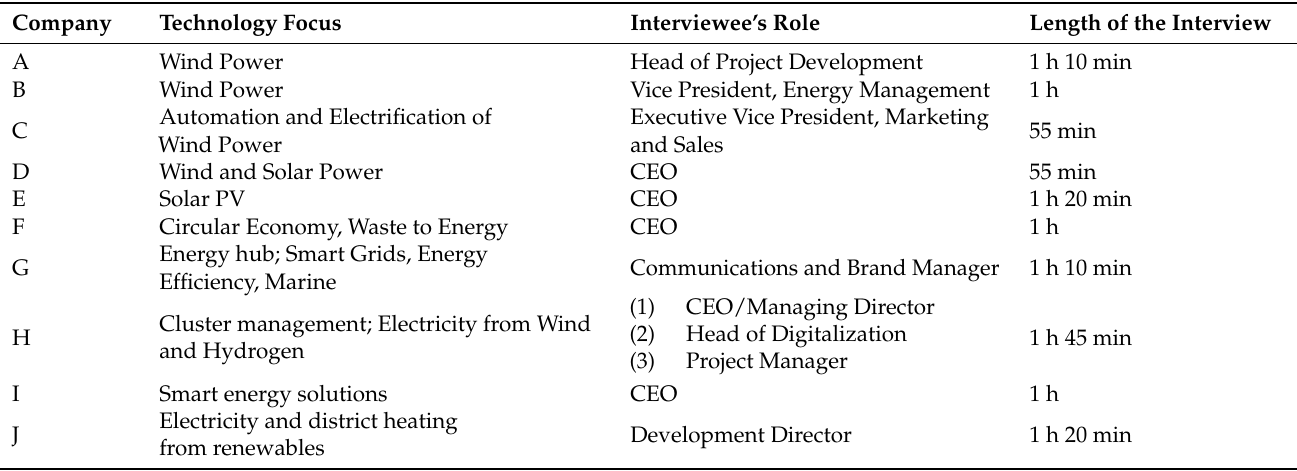
Table 2. Details of the companies in the case